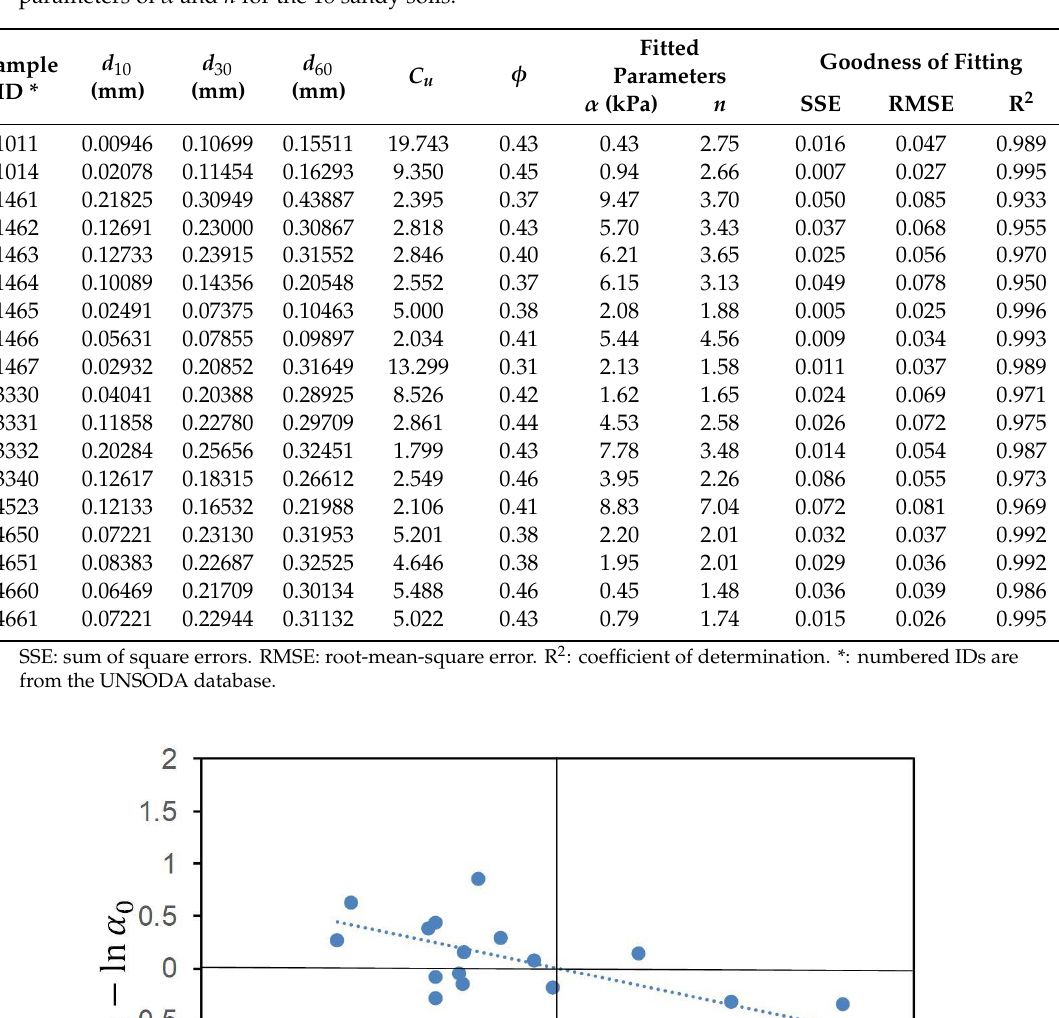
Table 1. Soil gradation parameters, porosity values and best fitted water retention curve (WRC) parameters of α and n for the 18 sandy soils.